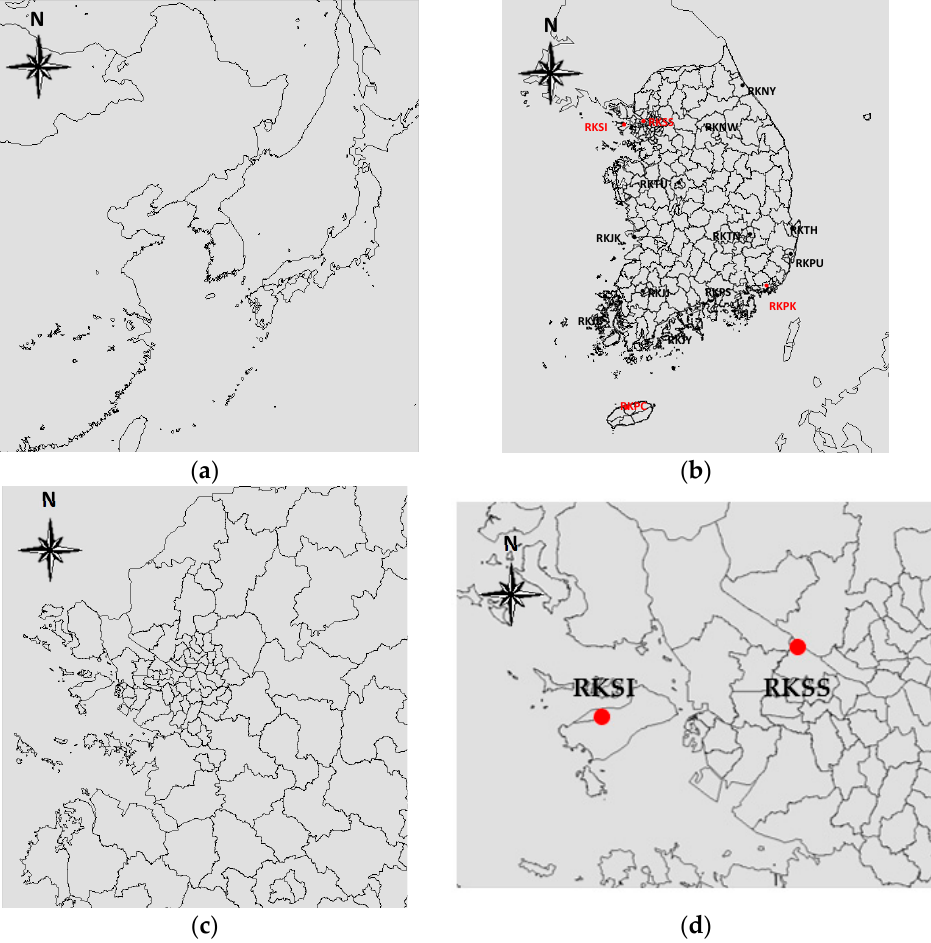
Figure 1. Nested domains of CMAQ model ( a ) East Asia (27 km × 27 km) domain, ( b ) Korean Peninsula (9 km × 9 km) domain ( c ) Capital Area (3 km × 3 km), ( d ) Airport Area) (1 km × 1 km).